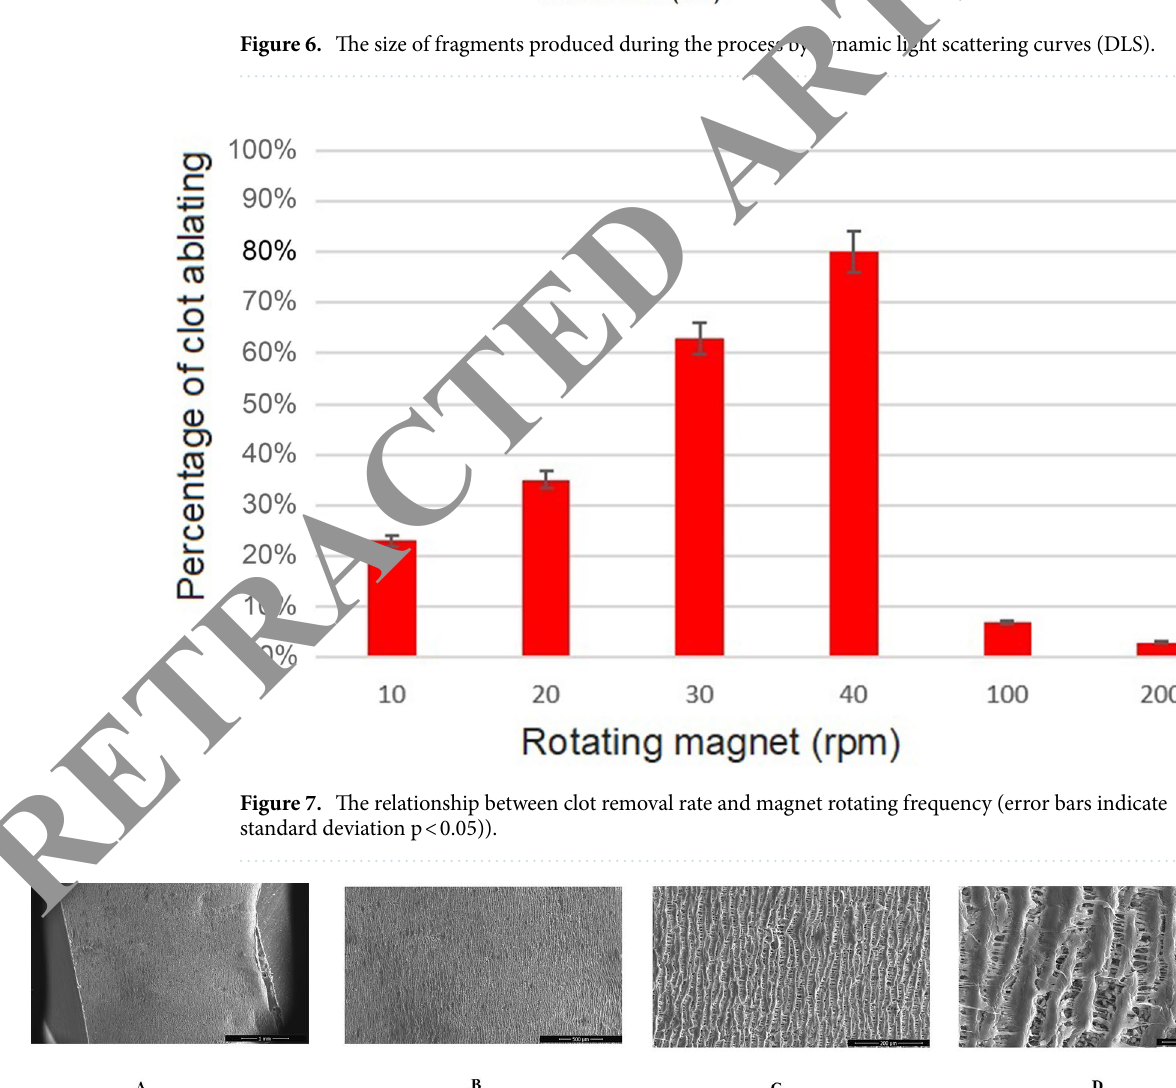
Figure 8. Field-emission scanning electron microscope (FSEM) images of the artificial vessel after 4 hr of NMT in different scales. ( A ) 1 µm, ( B ) 500 nm, ( C ) 200 nm, ( D ) 50